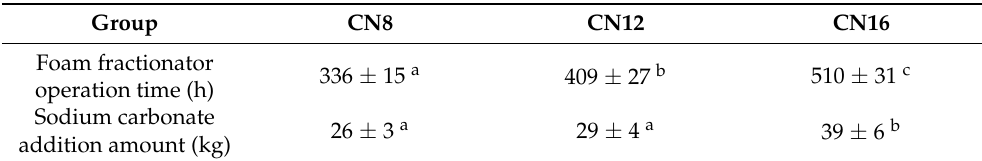
Table 2. The culture management for biofloc-based tank systems during an 8-week intensive produc- tion trial of P. vannamei with three input C/N ratios (means ± S.D., n = 3).